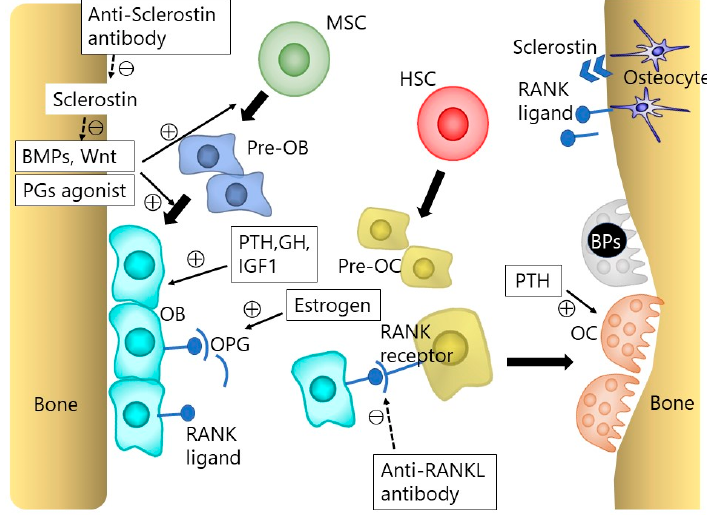
Figure 1. The osteoblast (OB) and osteoclast (OC) lineage cells. Bone homeostasis is maintained by the interaction between osteoblasts, osteoclasts, and osteocytes. Osteoblasts arise from mesenchymal stem cells (MSCs), and osteoclasts from hematopoietic stem cells (HSCs). Osteoblasts can also become osteocytes. Bone morphogenetic proteins (BMPs) and Wnt signaling play an important role in osteoblastogenesis. The receptor activator of nuclear factor κ B ligand (RANKL)-RANK interaction is essential for osteoclast differentiation. The RANKL produced by osteoblasts and osteocytes binds to RANK on the osteoclast precursor cells, which triggers the differentiations into osteoclasts. Osteoblast lineage cells also express osteoprotegerin (OPG), which is a soluble decoy receptor of RANKL, blocking RANKL by binding to its cellular receptor RANK. This RANKL-RANK-OPG system plays an important role in bone homeostasis. BP indicates bisphosphonate; GH, growth hormone; IGF1, insulin-like growth factor 1; PG, prostaglandin; PTH, parathyroid